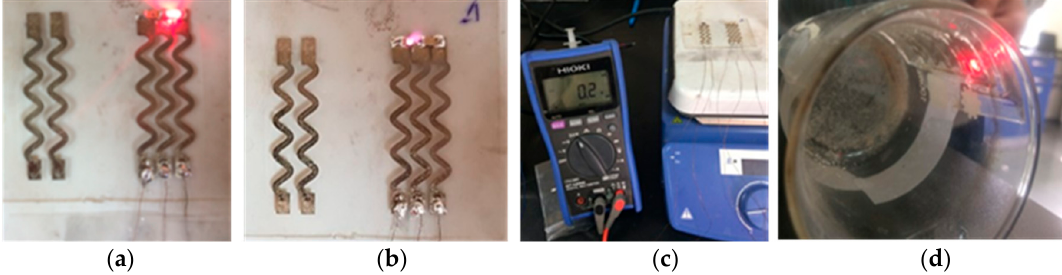
Figure 18. Testing stretchable sensor functionality. ( a ) Red LED is turned ON; ( b ) infrared LED is turned ON; ( c ) PD signal in response to ambient light is acquired; ( d ) red LED is ON when sensor is bent around a concave curvature.